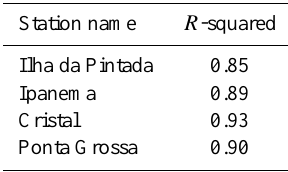
Table 2. Comparisons between observed and simulated water ele- vation data at the gauging stations ( R